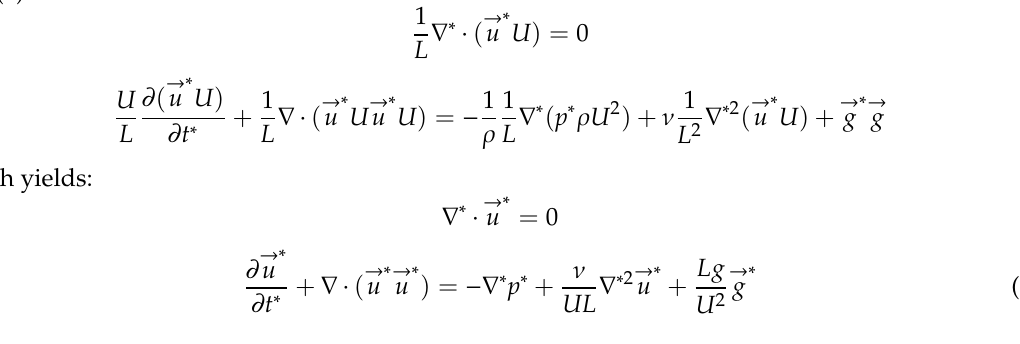
Table 4. Reference and non-dimensional